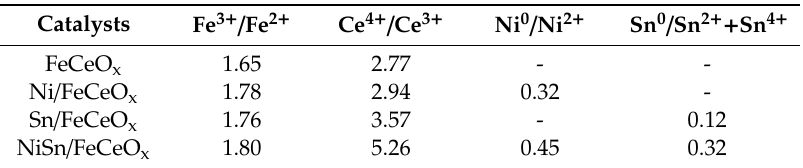
Table 3. Surface Fe 3 + / Fe 2 + , Ce 4 + / Ce 3 + , Ni 0 / Ni 2 + , and Sn 0 / Sn 2 + + Sn 4 + ratio of reduced FeCeO x , Ni / FeCeO x , Sn / FeCeO x , and NiSn / FeCeO x catalysts.